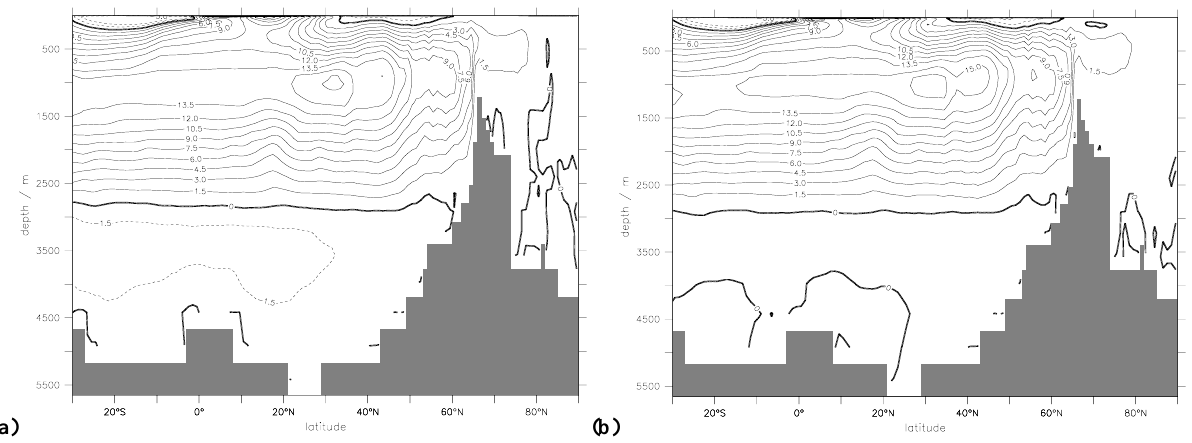
Fig. 14. AMOC in Sv for PI control (a) and mid-Pliocene (b) simulations of experiment 2. Overturning rates are time averages that have been calculated from 30-yr climatologies. Positive values represent a clockwise circulation, contour line interval is 1.5Sv. The grey area indicates bottom topography calculated from the basin-wide zonal minimum sea floor